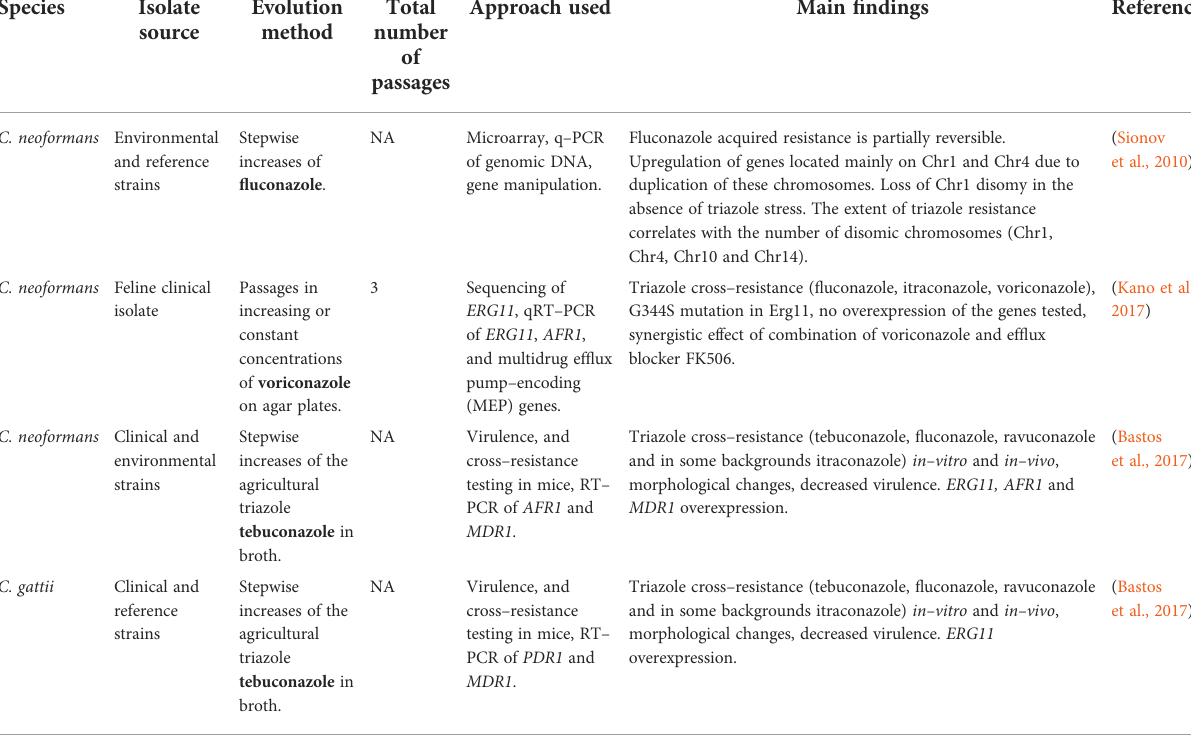
TABLE 5 Development of triazole resistance in Cryptococcus spp. isolates undergoing in – vitro